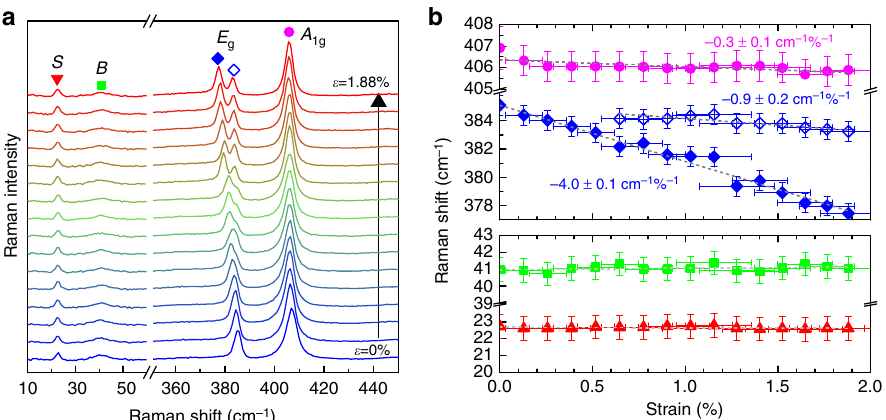
Fig. 3 Raman spectra of bilayer MoS 2 under uniaxial strain. a Raman spectra of bilayer MoS 2 as a function of uniaxial strain. From left to right, the shear, breathing, split E g , and A 1g modes are denoted by the triangle, square, diamond, and circle symbols, respectively. b The peak positions for intralayer phonon modes (upper panel) and interlayer shear and breathing modes (lower panel) as a function of uniaxial tensile strain. Error bars in strain come from the uncertainty in the estimate of the strain using the equation ε = t 0 θ / L 0 . The error bars in Raman shift are de fi ned by spectral resolution of the spectrometer